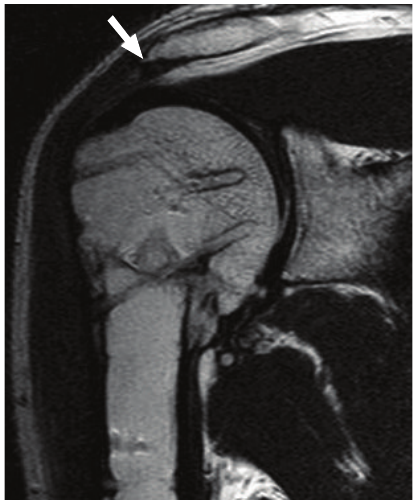
Figure 6: Although no fluid collection is seen in the subacromial bursa, the presence of a newly formed spur formation (arrow) is confirmed at the lateral margin of acromion (oblique coronal T2- weighted MR